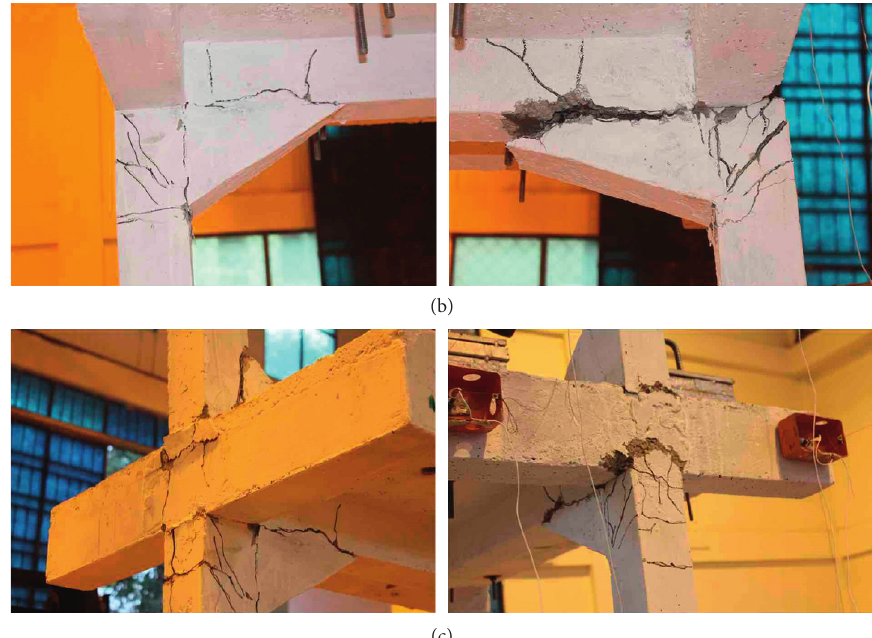
Figure 8: Observed damage in deficient models retrofitted with RC haunches, scheme-2. (a) Damage observed in beam-columns connection during self-check run. (b) Damage observed in beam-columns connection during 80% run. (c) Damage observed in beam-columns connection during 80% run.